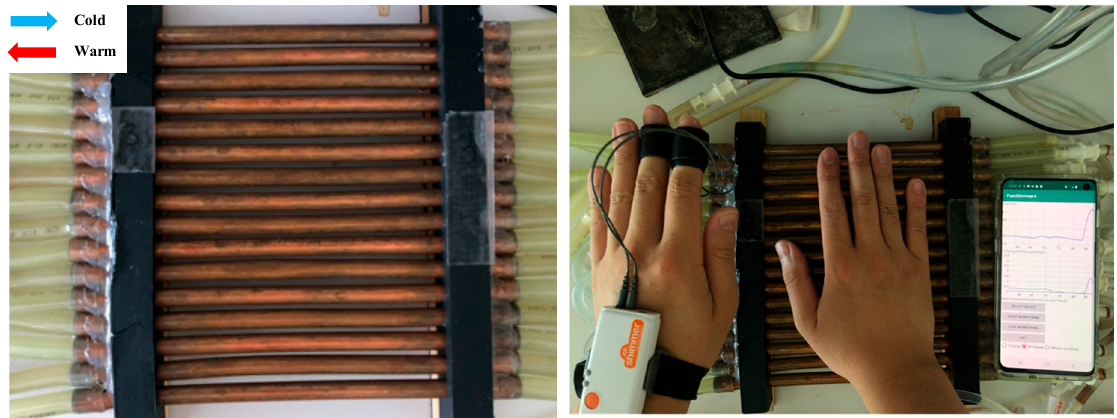
Figure 5. Thermal grill ( left ) and an example of data collection ( right ).